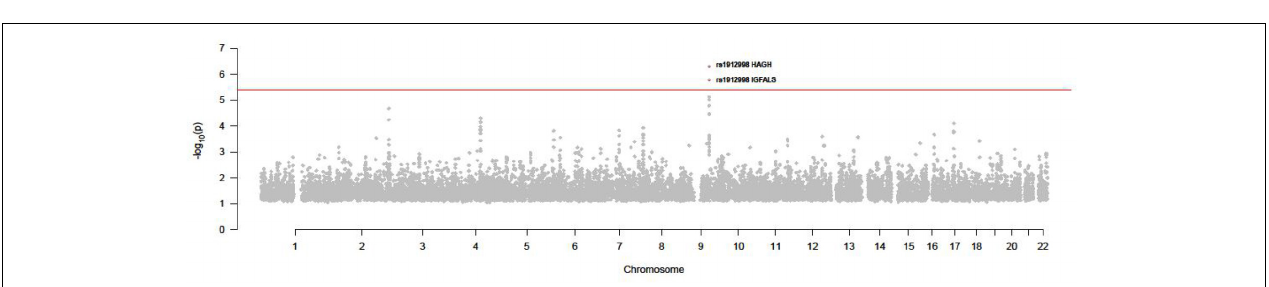
FIGURE 4 | P value of all SNPs in SMR test (GWAS and peripheral blood eQTL).